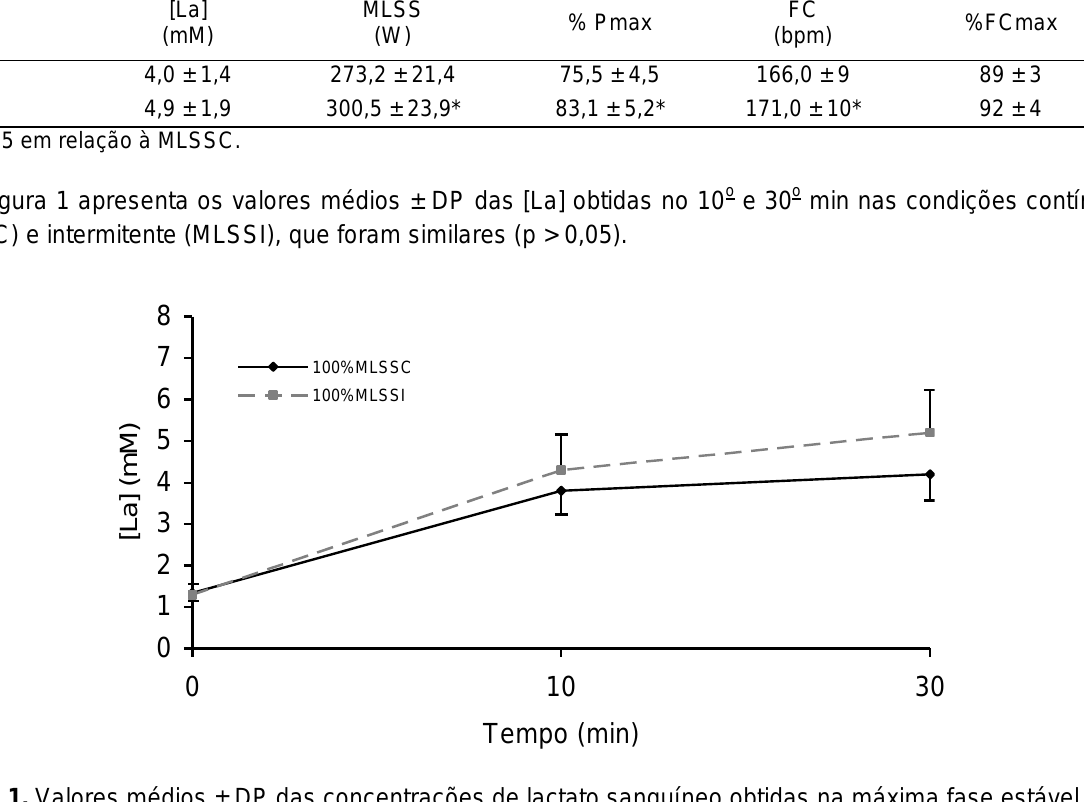
Figura 1. Valores médios ± DP das concentrações de lactato sanguíneo obtidas na máxima fase estável de lactato sanguíneo nas condições contínua (MLSSC) e intermitente (MLSSI). N = 10 Tabela 3. Valores de correlação obtidos da intensidade correspondente à máxima fase estável de lactato sanguíneo (MLSS) expressa em valores absoluto (W) e relativo à massa corporal (W/kg),